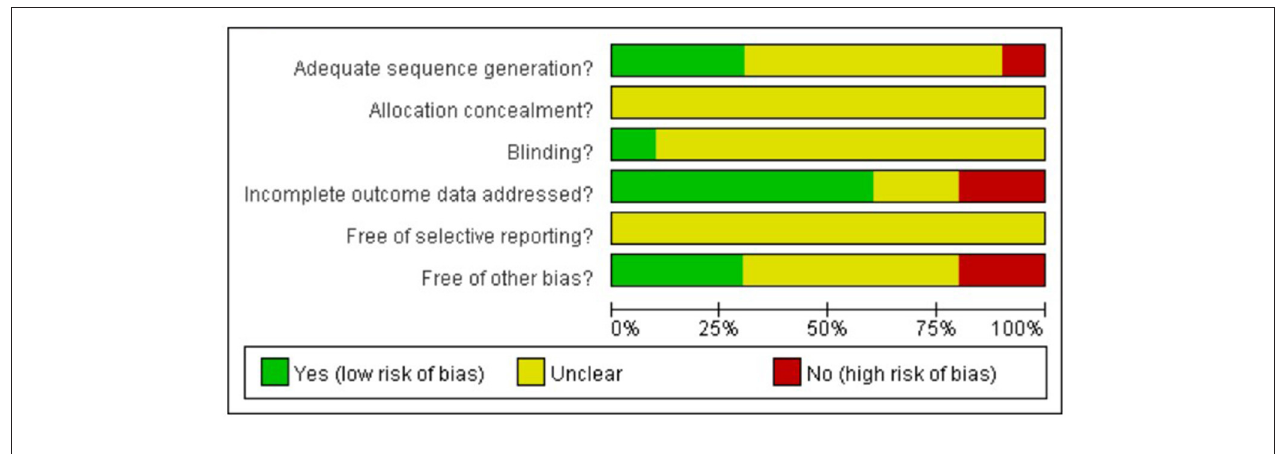
FIGURE 2 | Risk of bias diagram of included studies.